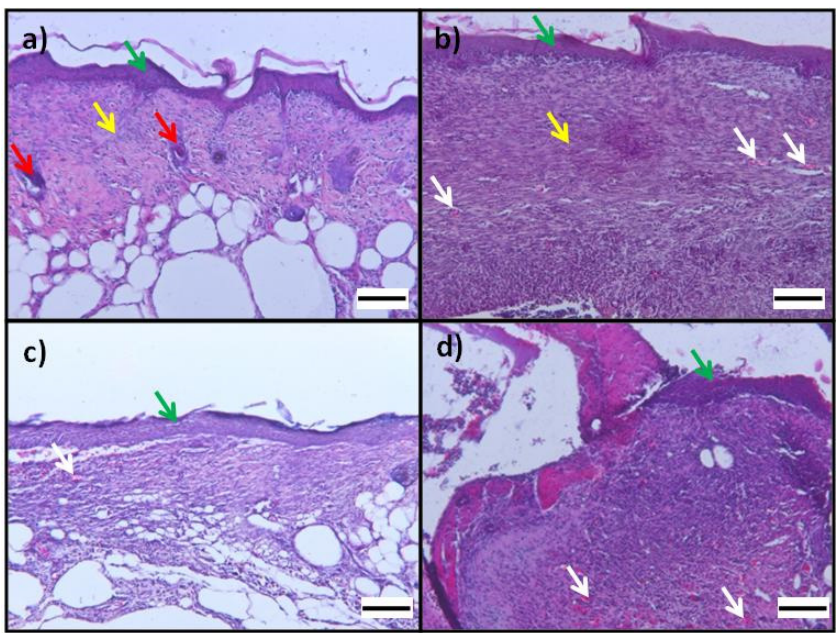
Figure 7. Photomicrographs of wound at day 14: Hematoxylin-eosin histological sections of excisional wound site obtained from a diabetic wound: ( a ) and ( b ) images from different mice treated with Plg-loaded fibrin scaffolds show epithelialization (green arrow), mild angiogenesis (white arrow), hair follicle (red arrow), mature connective tissue (yellow arrow); ( c ) and ( d ) images from different mice treated with Plg-unloaded fibrin scaffold show newly formed capillaries (white arrow) in granulation tissue and epithelialization (green arrow); OM 100× (scale bare = 100 μ m).